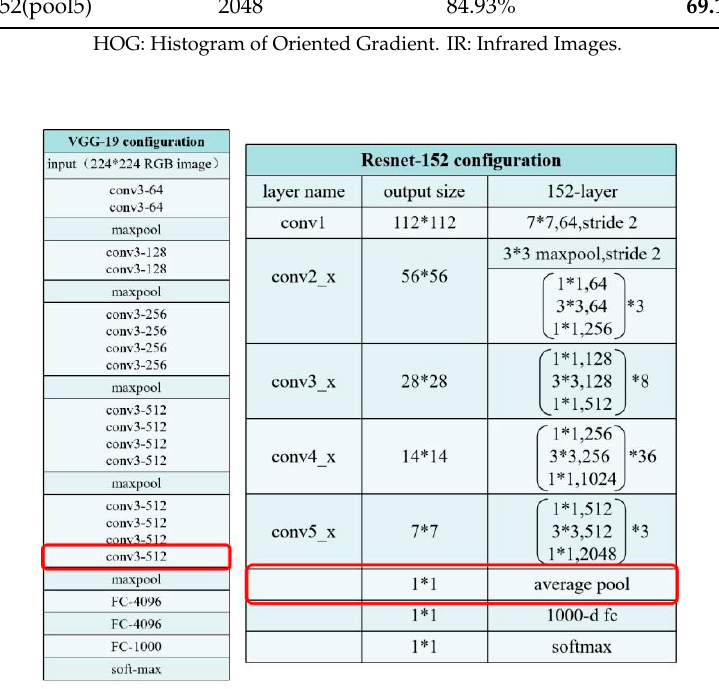
Figure 2. The location of the extracted features from VGG-19 or ResNet-152.